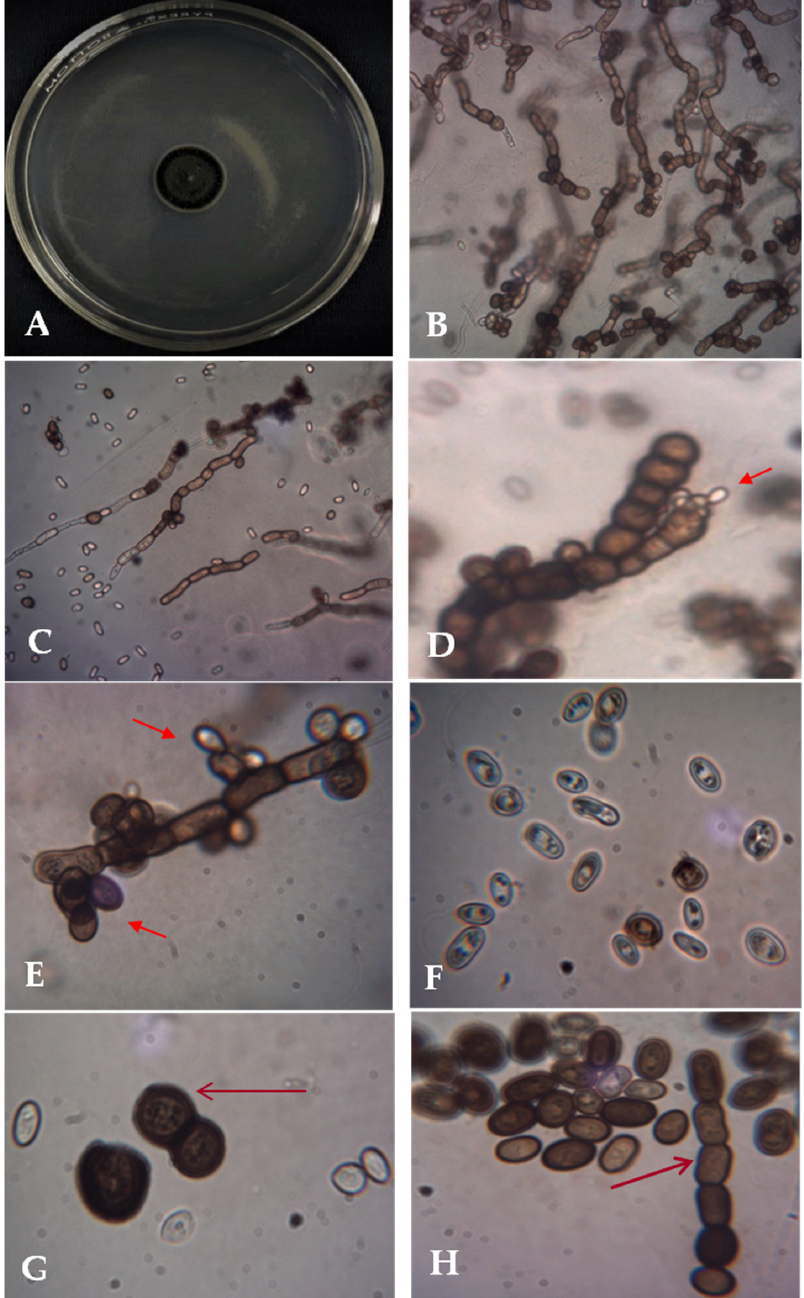
Figure 1. Macro- and microphotographs of A. pullulans AKW: the colony on PSA after 7 days at 30 °C ( A ), microscopic images of melanized hyphae with melanized conidia at 400 × ( B , C ), conidiogenesis at 1000 × (( D , E ), arrowed), hyaline and melanized blastoconidia ( F ), and dark brown chlamydoconidia and chains of arthroconidia at 1000× (( G , H ), arrowed).